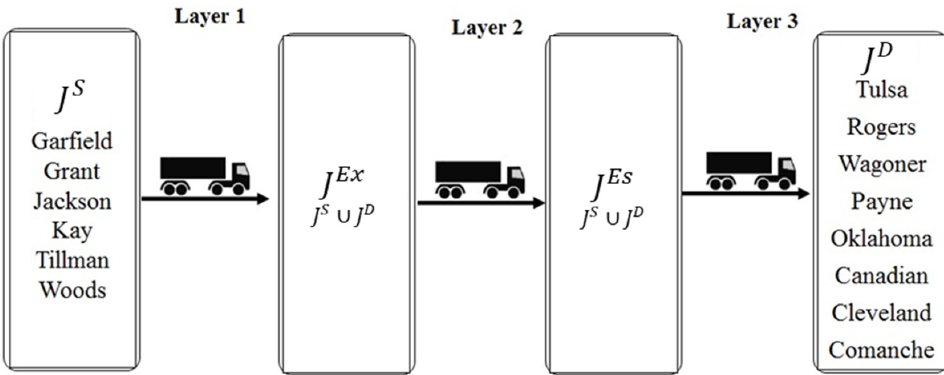
Figure 9. Network flow diagram of the algal biomass to biodiesel supply chain network for the state of Oklahoma. Supply locations ( 𝐽 (cid:3020) ) are those in Table 2, and demand regions ( 𝐽 (cid:3005) ) are those in Table 1. Both sets of locations are used as possible sites for extraction ( 𝐽 (cid:3006)(cid:3051) ) and transesterification ( 𝐽 (cid:3006)(cid:3046) ).